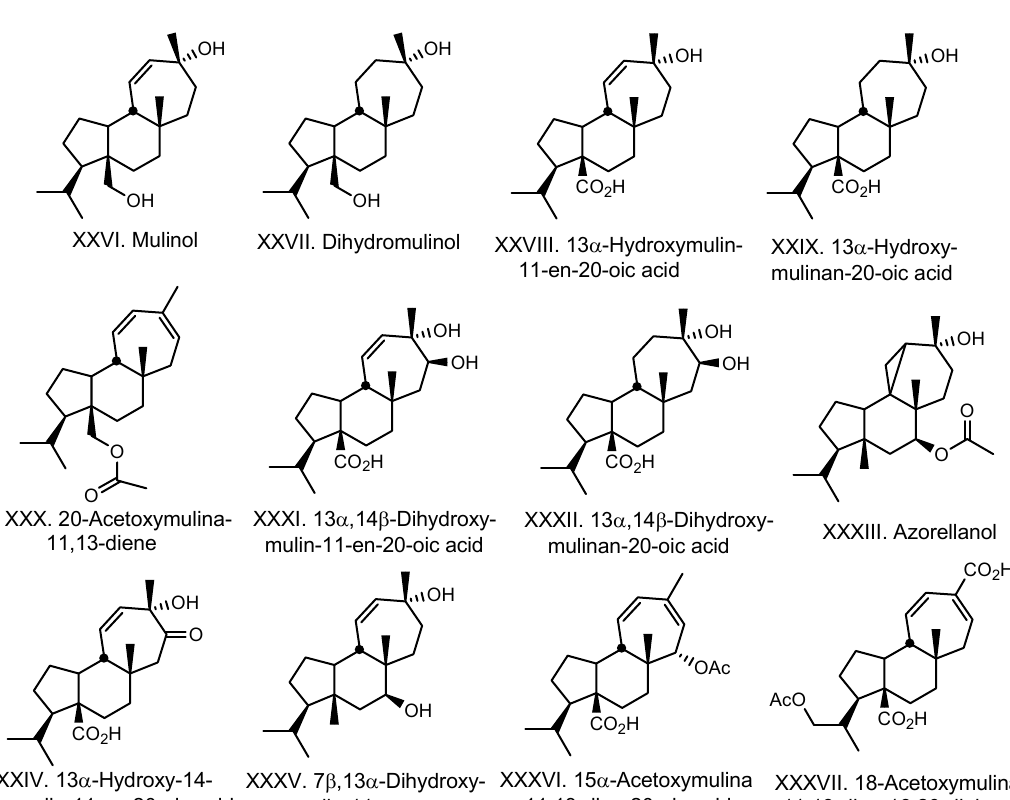
Figure A1. Chemical structures cited and listed in Table